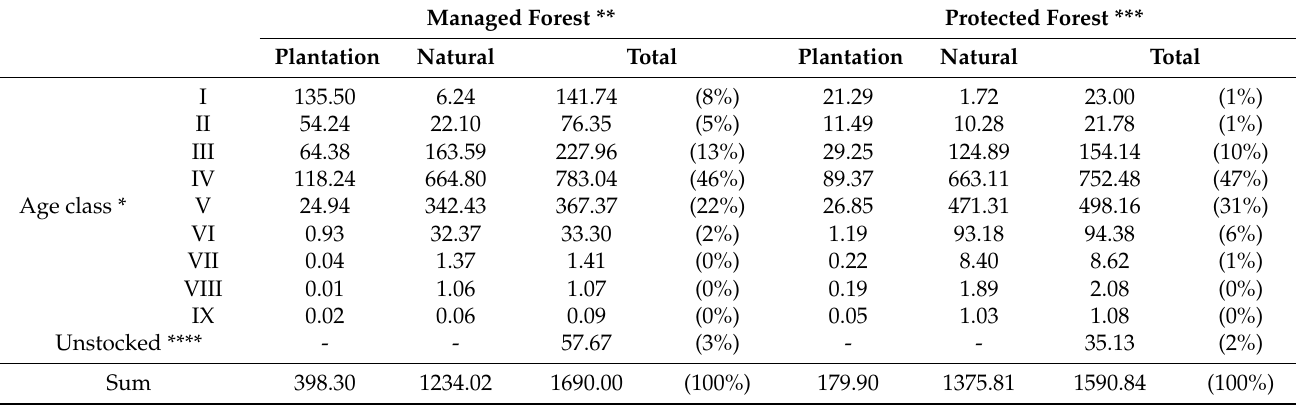
Table 6. Forest management areas by forest type and age class (1000 ha). Managed Forest